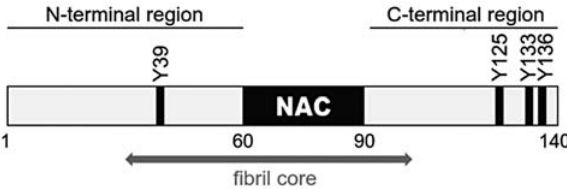
Figure 1. The α -synuclein sequence divided into the three structu- rally distinct parts. The N-terminal region, the middle NAC do- main, and the C-terminal region are shown. The proposed fibril co- re-forming region (residues ∼ 30 to ∼ 100) and positions of the four Tyr residues are